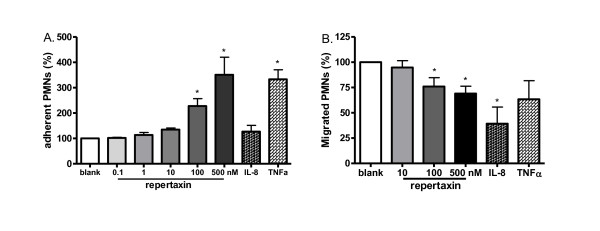
CXCR1/CXCR2 blockade enhances neutrophil adhesion and inhibits neutrophil transmigration through an endothelial cell monolayer. Isolated neutrophils from HC were pre-incubated with serial doses of repertaxin, IL-8 (10 ng/ml) or TNFα (2 ng/ml) before being loaded onto a glomerular endothelial monolayer or a transwell insert. After co-incubation of pretreated neutrophils with glomerular endothelial cells for 30 minutes for the adhesion assay (A, n = 5) or with transwell inserts coated with endothelial cells for 2 hours (B, n = 6), the number of adherent or migrated neutrophils were quantified by MPO activity assay. Results are presented as the percentages of adherent or migrated neutrophils after stimulation compared to control incubation. *, P < 0.05. HC, healthy control; IL; interleukin; MPO, myeloperoxidase; TNF, tumor necrosis factor.